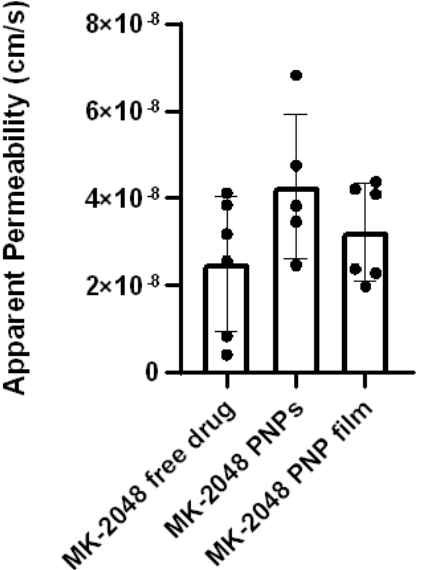
Figure 5. Ex vivo tissue permeability using In − Line Cell system for free MK − 2048 (N = 6), MK − 2048 PNP (N = 5), and MK − 2048 PNP film (N = 6). Results are reported as Mean ± SD.